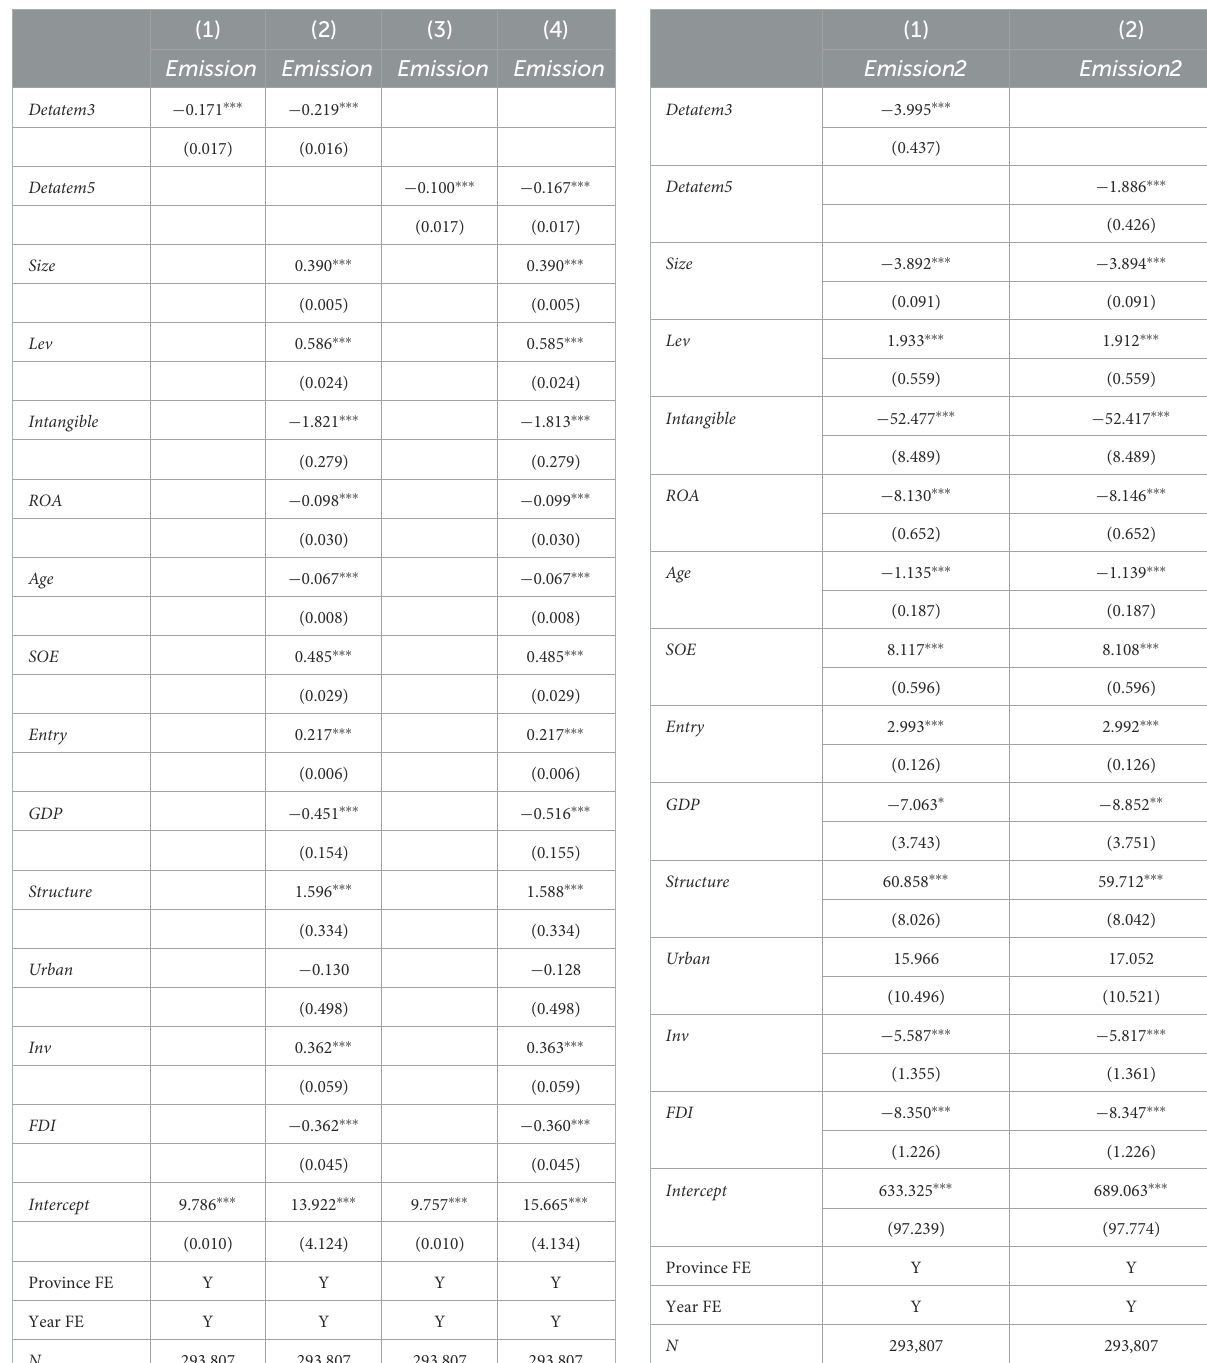
TABLE 3 Effects of climate change on firms’ SO2 emissions. TABLE 4 Alternate measurement of SO2